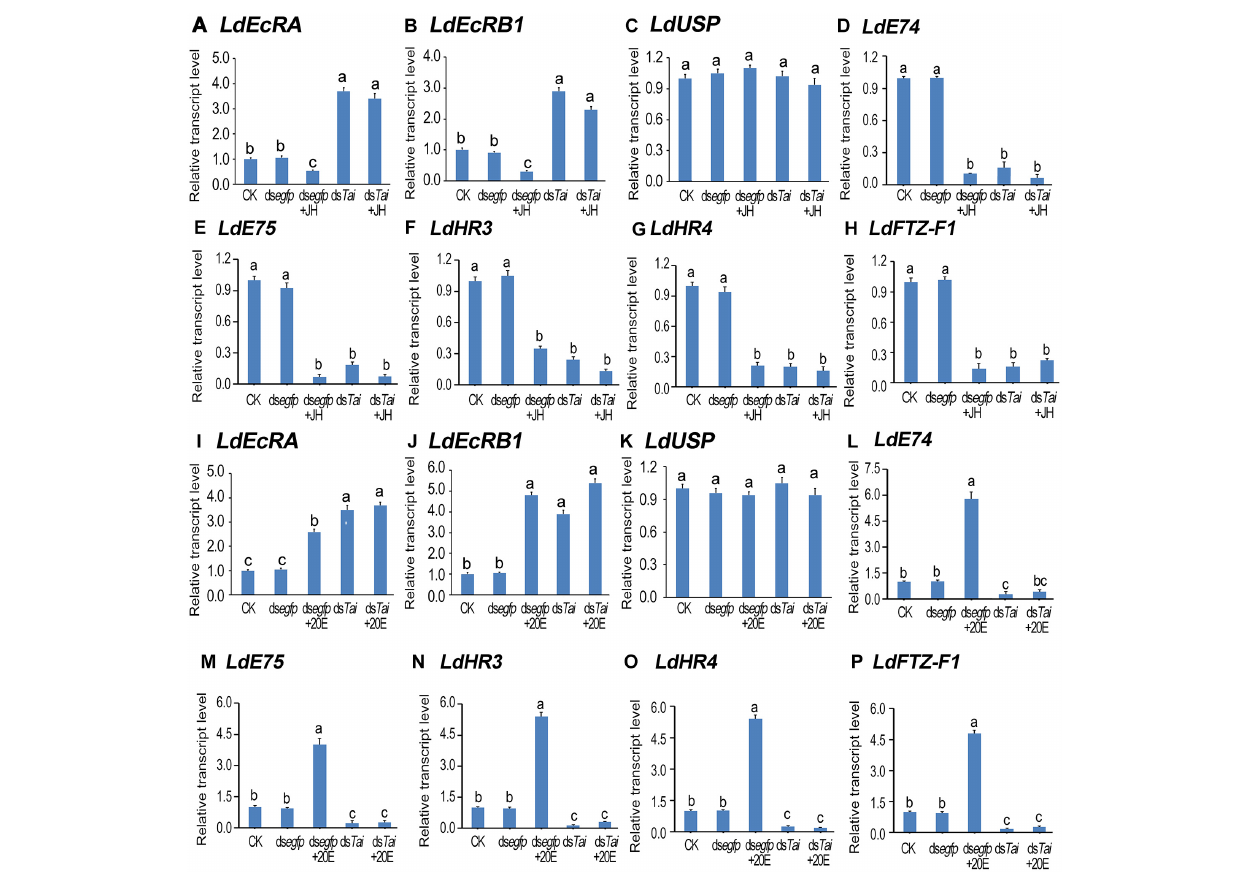
FIGURE 6 | Knockdown of LdTai disrupts 20E signaling in Leptinotarsa decemlineata . The newly ecdysed final instar larvae had ingested PBS (CK)-, ds egfp -, JH-, ds Tai - and ds Tai +JH-dipped leaves, or PBS (CK)-, ds egfp -, 20E-, ds Tai - and ds Tai +20E-immersed foliage for 3 days. The mRNA levels of eight 20E signaling transcripts LdEcRA (A,I) , LdEcRB1 (B,J) , LdUSP (C,K) , LdE74 (D,L) , LdE75 (E,M) , LdHR3 (F,N) , LdHR4 (G,O) and LdFTZ-F1 ) (H,P) were tested using qRT-PCR. The bars represent average values ( ± SE). Different letters indicate significant difference at P -value <